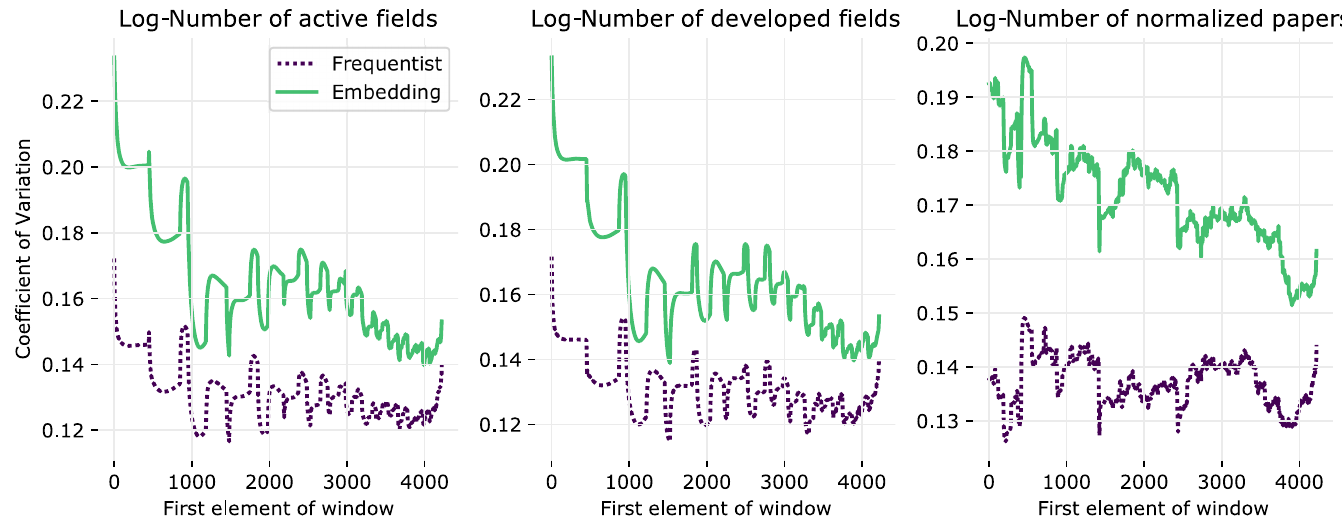
Fig 9. AUROC’s Coeff. of variation for institutions vs. data properties. Ratio between sample standard deviation and sample mean of the AUROC as a function of the (i) number of active fields, (ii) number of developed fields and (iii) normalized number of papers. Time windows are set as in the first experimental setup. Statistics are computed using a sliding window of size 1000 on the x axis.